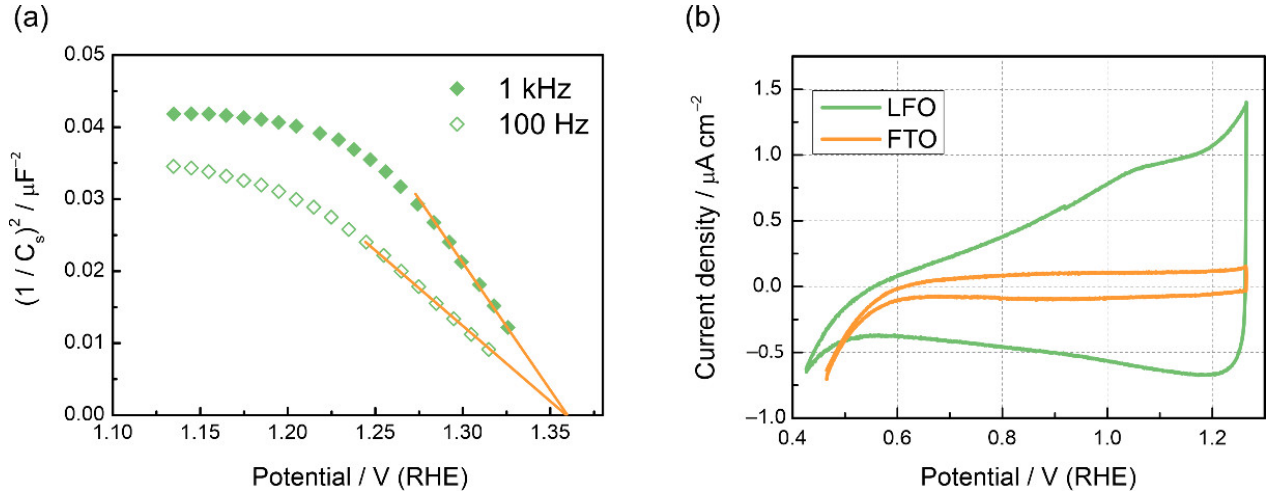
Figure 2. ( a ) Mott–Schottky plot for the LFO film in 0.1 M NaOH at 1000 Hz. ( b ) Dark voltammograms of the LFO film and bare FTO in 0.1 M NaOH at 10 mV s −1 .